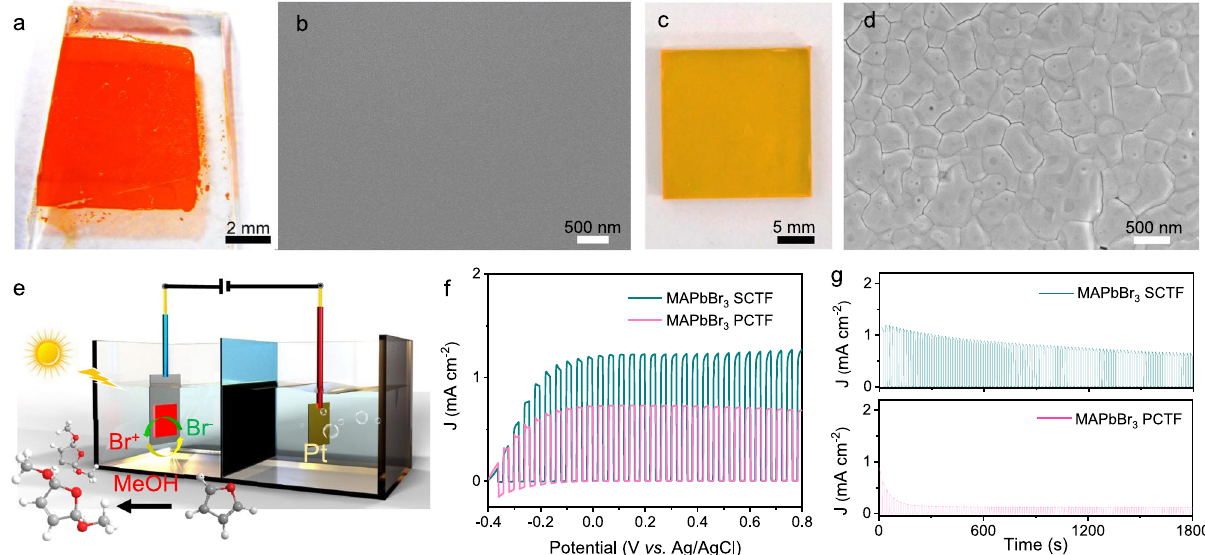
Fig. 1 Comparison of MAPbBr 3 SCTF with PCTF. Optical microscopy and SEM images of MAPbBr 3 SCTF ( a , b ) and PCTF ( c , d ). e Schematic con fi guration of the proposed working principle of MAPbBr 3 SCTF-based (or PCTF-based) PEC cells. f Linear sweep voltammetry (LSV) of MAPbBr 3 SCTF-based and PCTF-based photoelectrodes. g Chronoamperometric trace of MAPbBr 3 SCTF-based and PCTF-based photoelectrodes recorded at an applied potential of 0.2 V vs.